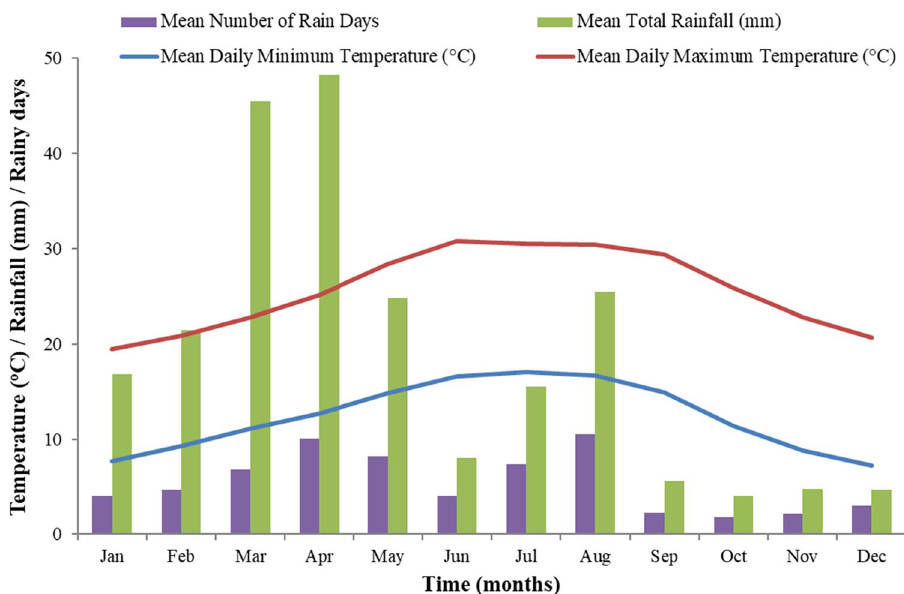
Fig. 2 Average monthly rainfall and average monthly tempera- ture of the study